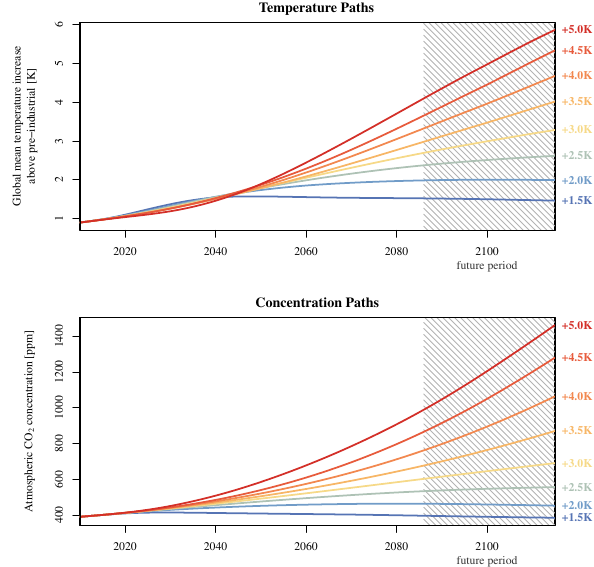
Fig. 2. Trajectories of global mean temperature increase used in this study and corresponding atmospheric CO 2 concentrations from the MAGICC6 model. The shaded area indicates the the time period for which the temeperature targets are calculated.